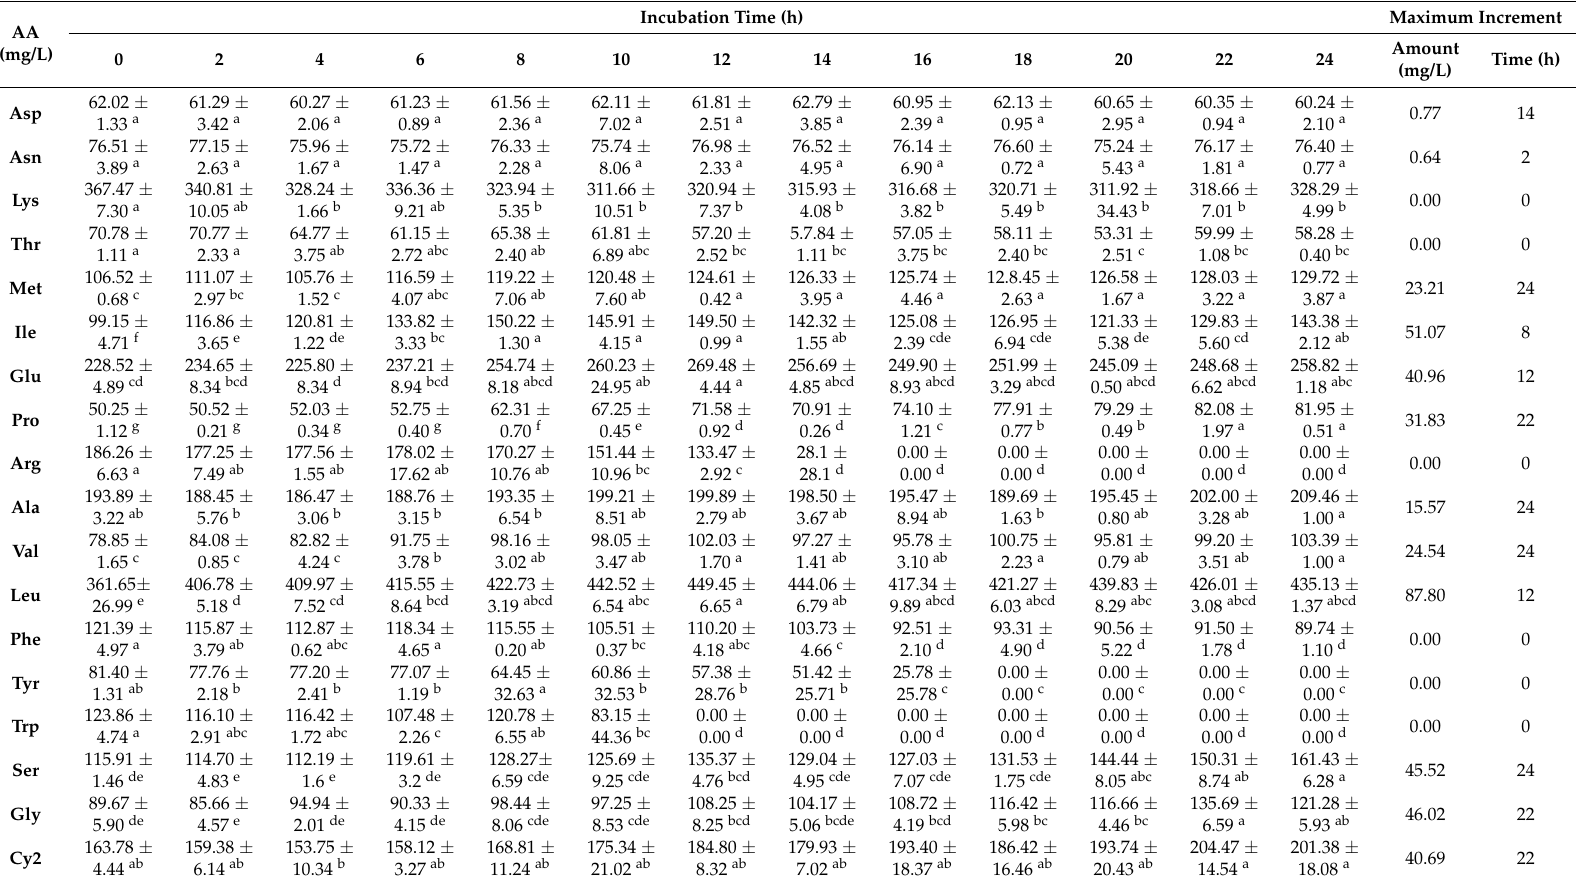
Table 6. The amino acid production profile of P. acidilactici